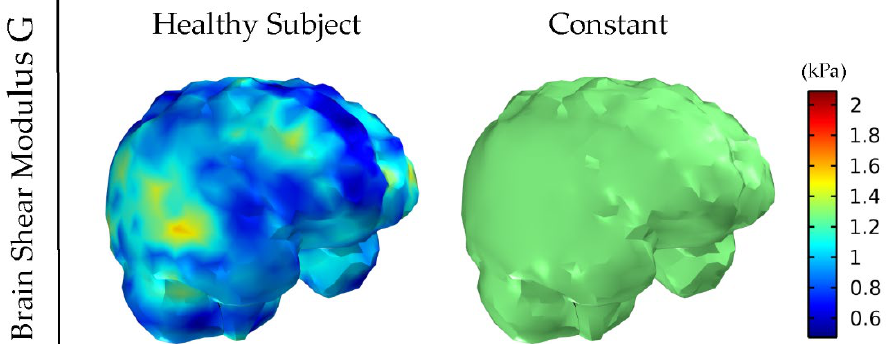
Figure 1. Healthy subject’s shear modulus, G, of the brain derived by MRE. The value for the constant shear modulus case also considered for comparison is the average of the healthy subject’s data.